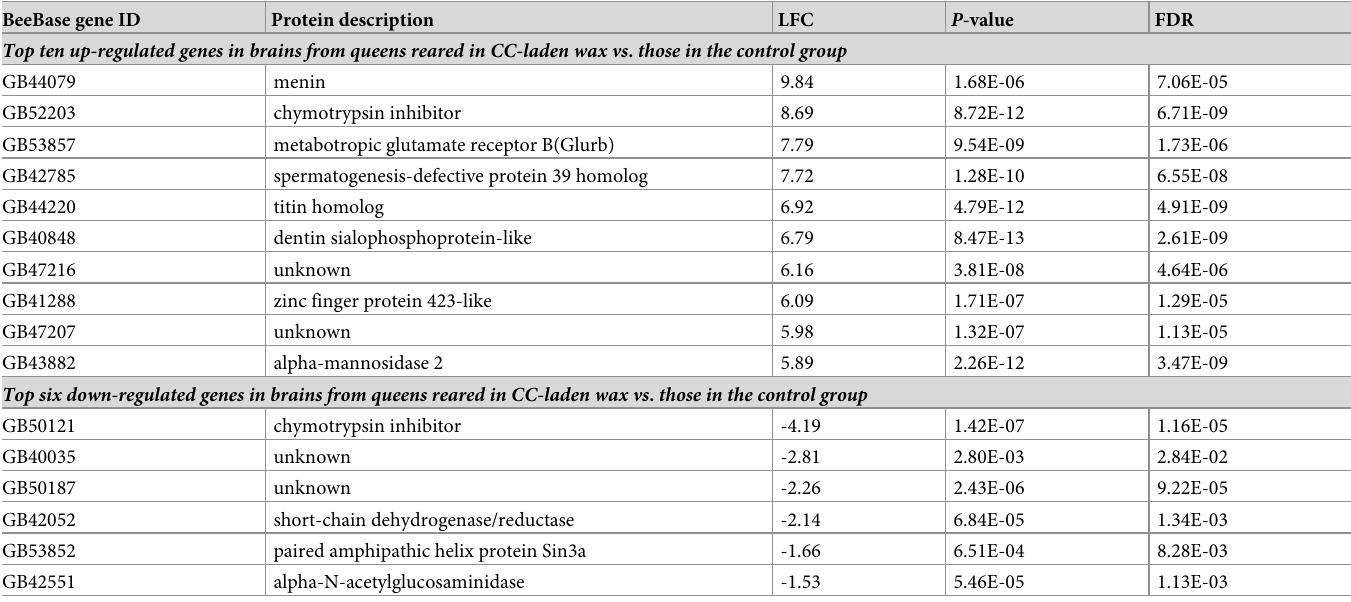
Table 2. The top ten and bottom six genes that were differentially expressed in brain tissue from queens reared in wax contaminated with a mix of chlorpyrifos and chlorothalonil ("CC") compared to those reared in untreated wax (control group), ranked by their log 2 fold change (LFC). "FDR" is the false discovery rate. BeeBase gene ID Protein description LFC P -value FDR Top ten up-regulated genes in brains from queens reared in CC-laden wax vs . those in the control group